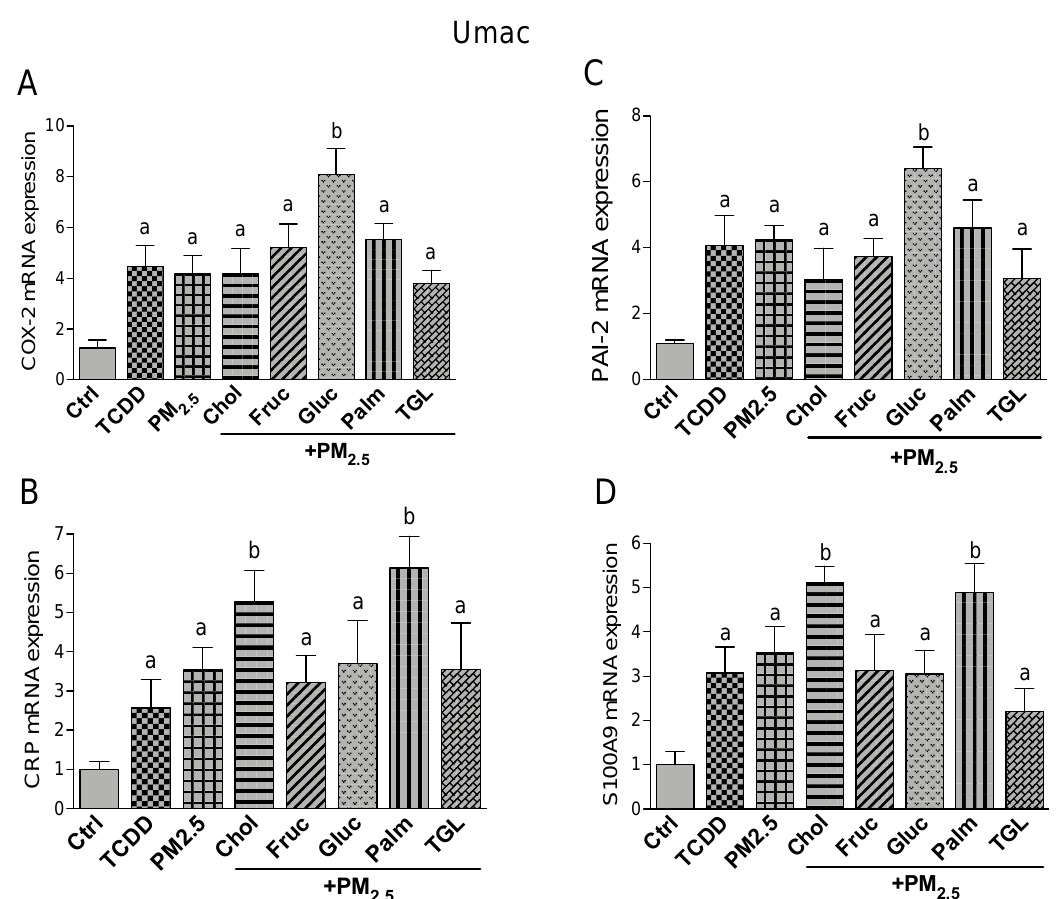
Figure 4. E ff ect of nutritional compounds on PM 2.5 -induced expression of atherogenic markers in Umac; Cells were treated with 1 nM TCDD and 10 µ g / mL PM 2.5 for 24 h. The e ff ect of nutritional factors cholesterol (Chol, 10 µ g / mL), fructose (Fruc, 25 mM), glucose (Gluc, 25 mM), palmitic acid (Palm, 5 µ M), and triglyceride (TGL, 10 µ g / mL) was tested in presence of PM 2.5 after 24 h treatment. Control cells were treated with the corresponding vehicle. The mRNA expression of ( A ) COX-2; ( B ) CRP; ( C ) PAI-2, and ( D ) S100A9 was analyzed by qPCR. The expression was corrected against the housekeeping gene β -actin. a significantly higher than Ctrl; b significantly higher than cells treated with PM 2.5 only p < 0.05.